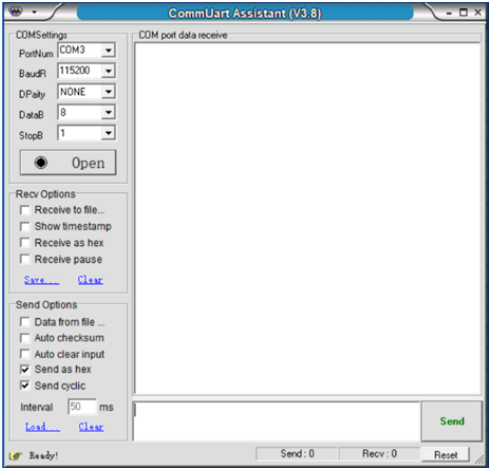
Figure 11. User interface of the stress wave communication system.